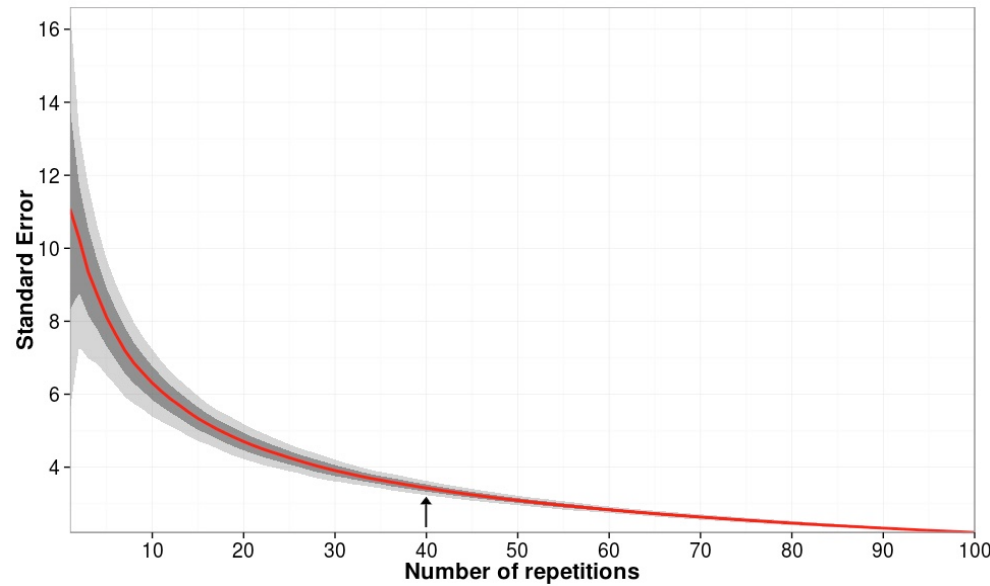
Figure 5. Results of sensitivity analysis about the effect of the number of experiment repetitions on the error surrounding mean estimates of erosion in the main Barranco near Mas d’Is. Red line is the mean of all recombinations at the specified number of repetition. The dark grey shaded region denotes 1 SD, and the lighter grey shaded region denotes 2 SD, based on the range of values from all 100 recombinations at each number of